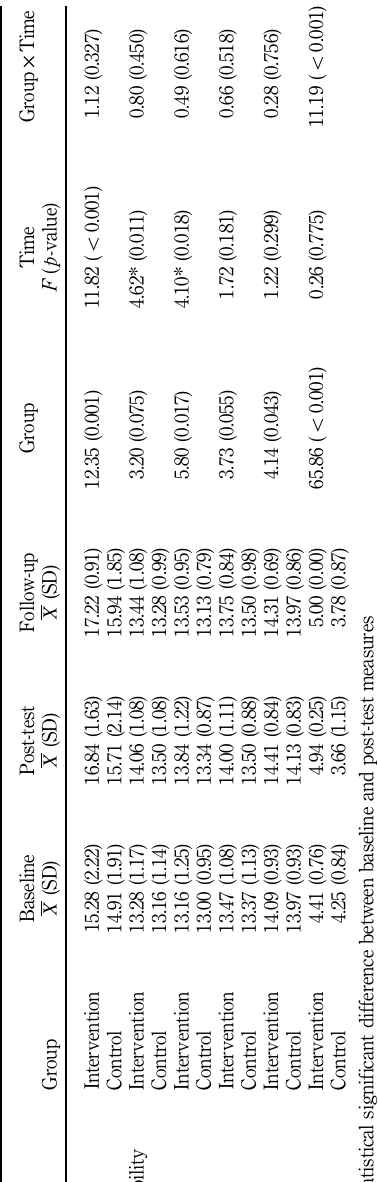
knowledge, perceived susceptibility, severity, benefits and barriers of preventive action for dengue hemorrhagic fever over